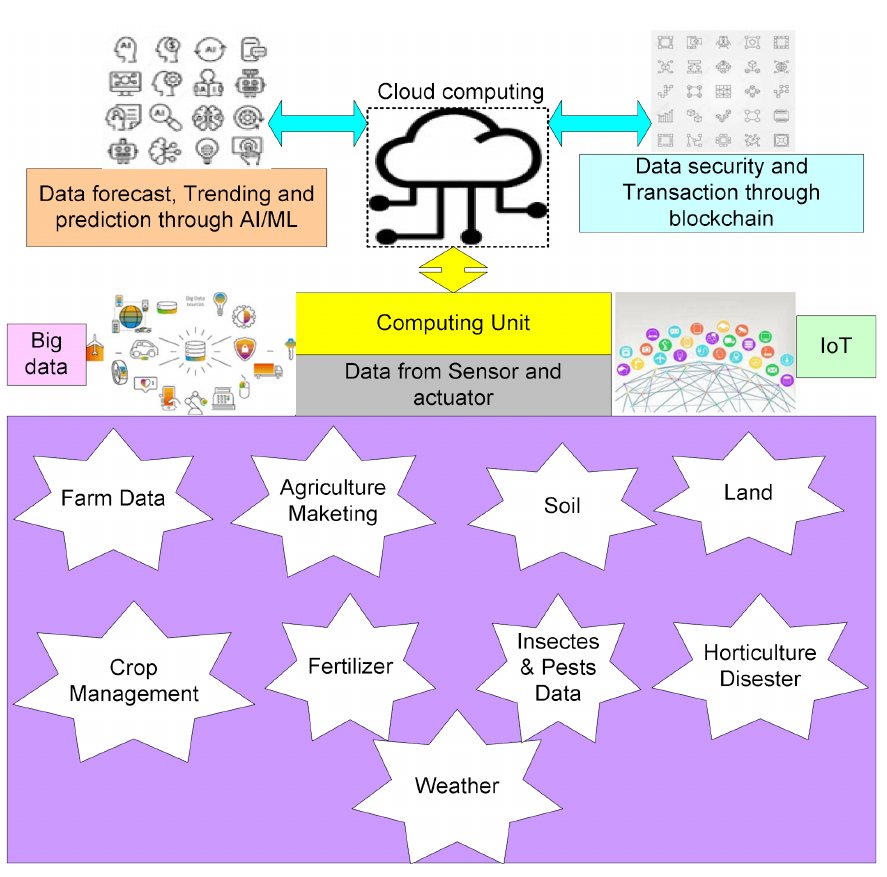
Figure 7. Hybrid architecture for Horticulture